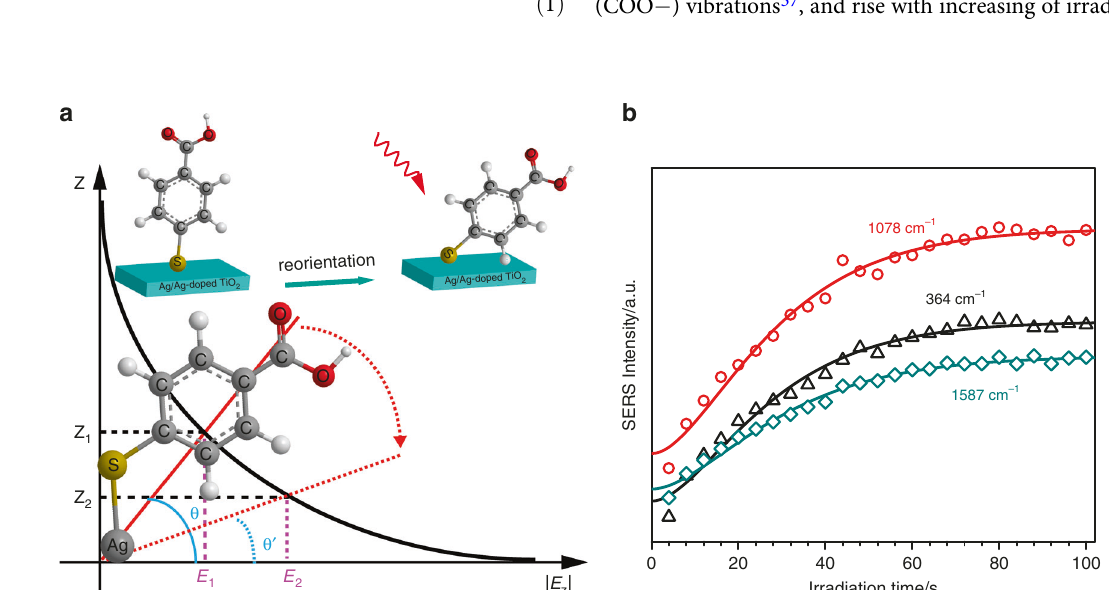
Fig. 7 Reorientation of 4MBA molecules. a Physical model of 4MBA molecule movement in an exponentially decaying electromagnetic fi eld with increasing of the distance Z perpendicular to the surface of substrate. The inset is the reorientation schematic of 4MBA molecule on the surface of the Ag/ Ag-doped TiO 2 substrate under laser irradiation. b Irradiation time-dependent SERS peak intensities of 4MBA at 364, 1078, and 1587 cm − 1 , experimental data (symbols) and theoretical results (solid